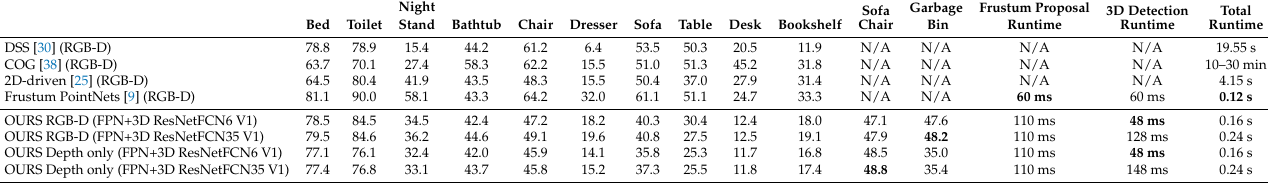
Table 5. 2D/3D detection results based on YOLO v3 vs. FPN. 2D detection is based on RGB images.